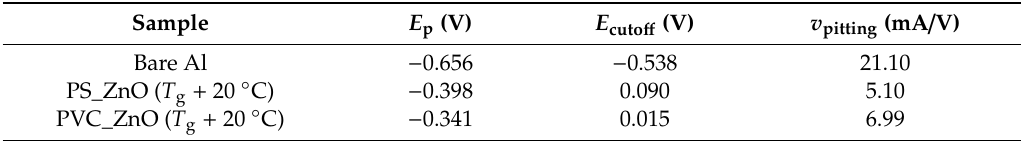
Table 2. Pitting test results for the bare Al substrate and both PS_ZnO and PVC_ZnO coating, tested in 3.5 wt % NaCl aqueous solutions .